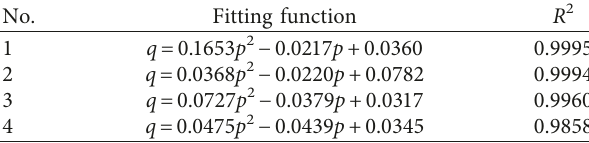
Table 2: Relationship between gas flow rate and gas